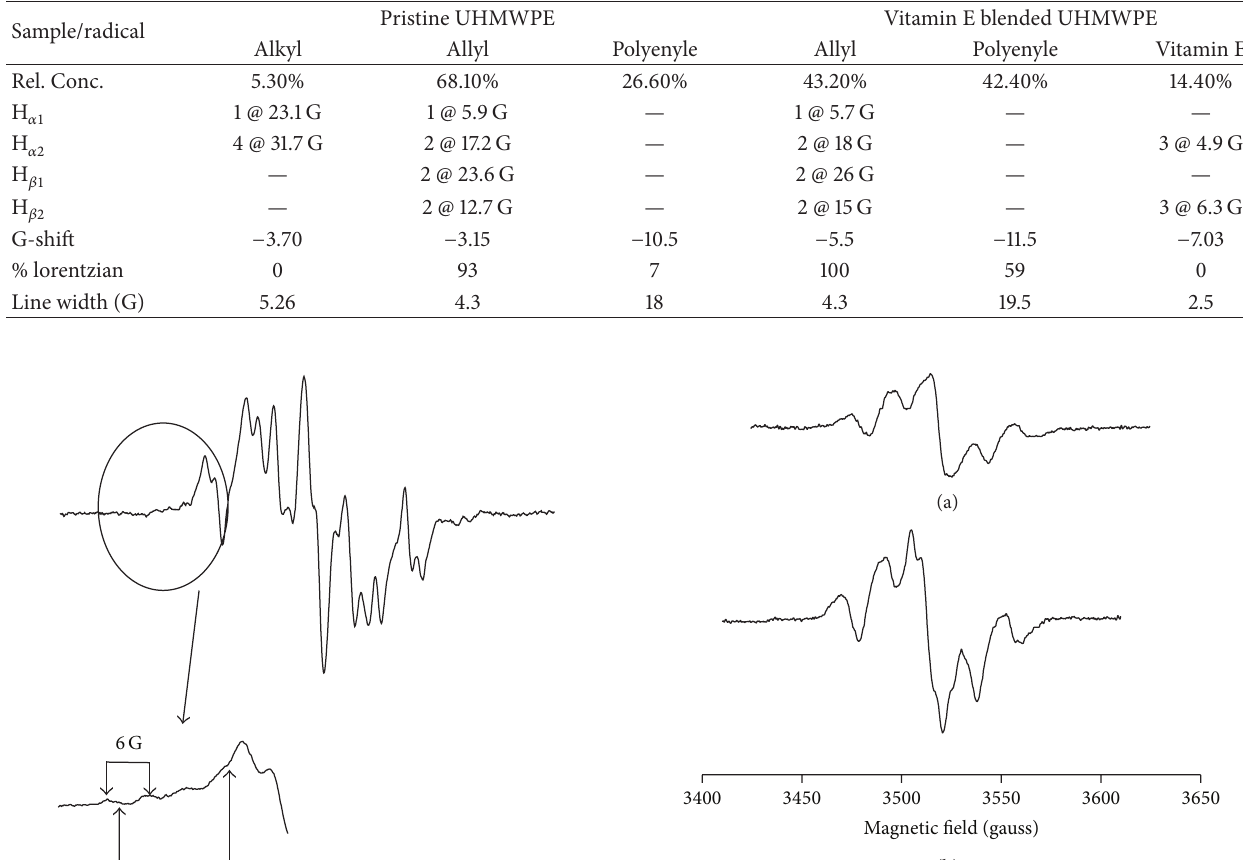
Table 1: Relativeconcentration ofradicals, spin1/2coupling constants,% lorentzian, and linewidth for100 kGy irradiated pristineUHMWPE and vitamin E blended UHMWPE powder used as input for WinSim simulation software.